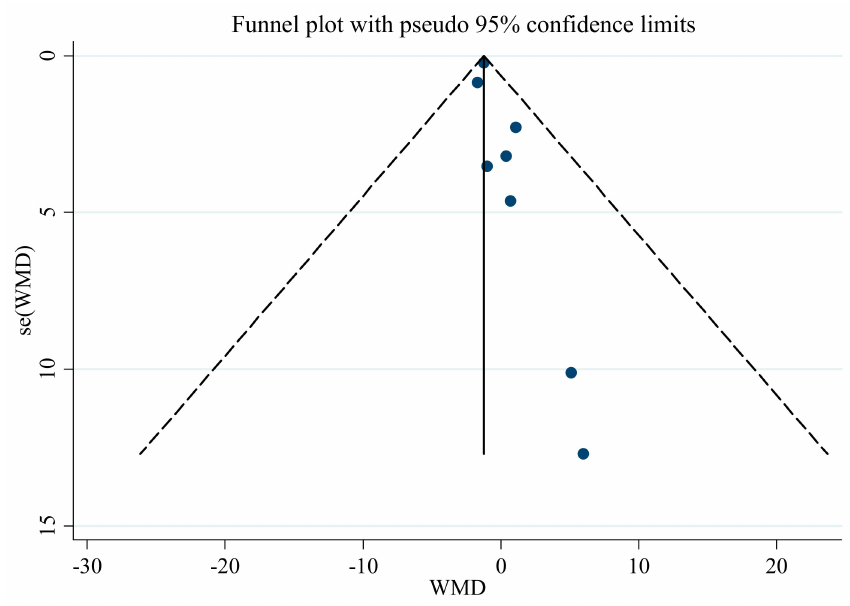
Figure 9. Funnel plot for the effect of saffron supplementation on